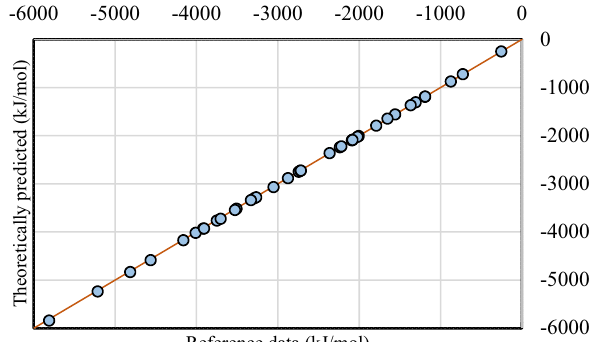
Figure 1. Comparison of theoretically predicted and experimentally determined combustion enthalpies. The data shown are from the CCSD(T)-F12 computations, because the DSD-PBEB86 values are visually indistinguishable on the plotted range of enthalpy